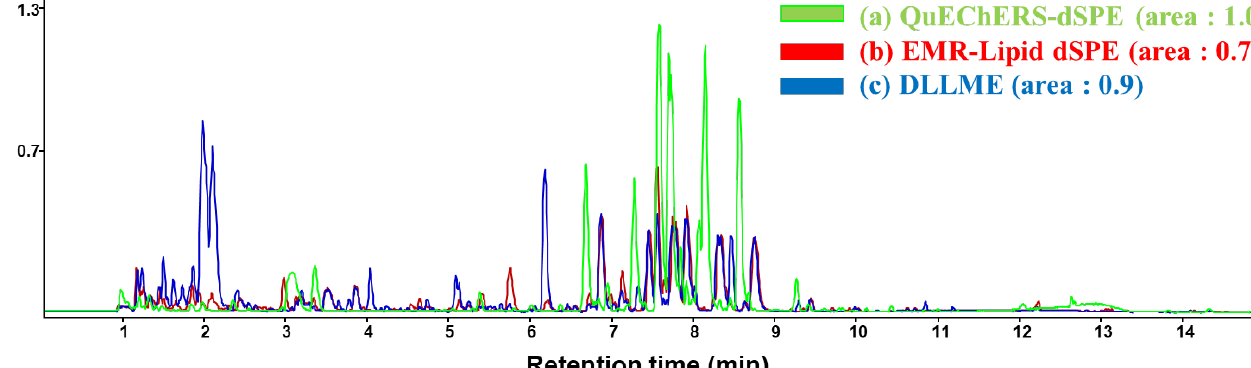
Figure 2. Total ion chromatograms of matrix residues after sample pretreatments of soft-gel by ( a ) QuEChERS-dSPE, ( b ) EMR-Lipid dSPE, and ( c ) DLLME methods.